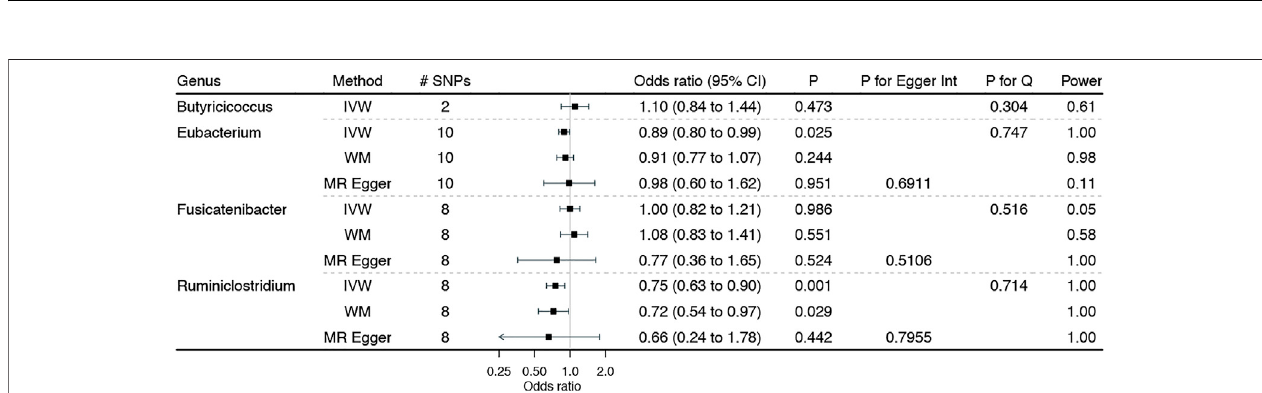
FIGURE 2 | Associations of genetically predicted genera of gut microbiota dominated among individuals of European ancestry on Barrett ’ s esophagus. IVW: inverse variance weighted method with multiplicative random effects expect for Butyricicoccus using the fi xed-effect inverse variance weighted method due to the inclusion of two genetic instruments; WM: weighted median